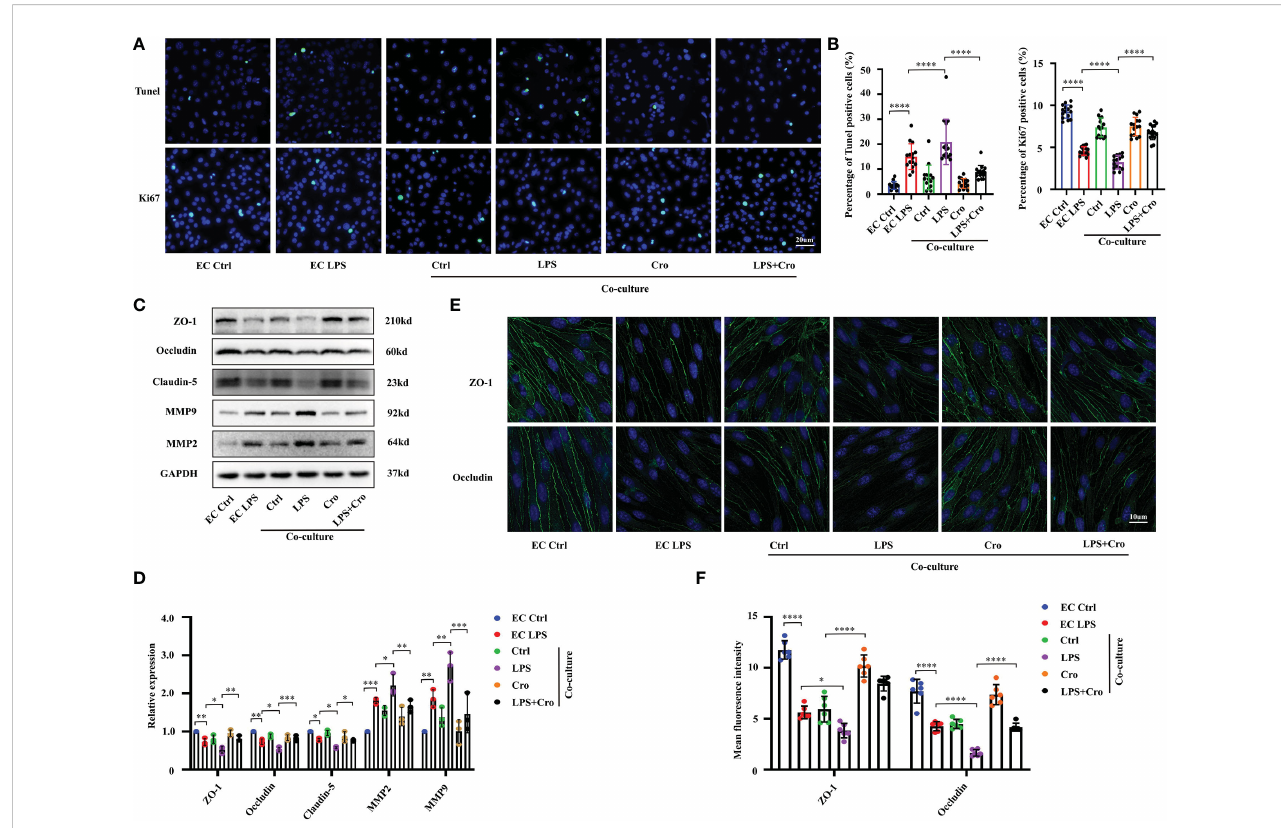
FIGURE 6 Cromolyn treatment protected BMVEC functions from LPS-induced MCs activation. (A) Apoptotic BMVECs and Ki-67-positive cells were examined by Tunel staining and Ki-67 IF staining, respectively (400x, n=3). (B) Quanti fi cation of Tunel-positive and Ki-67-positive BMVECs (n=3). (C) Expression levels of MMP9/ 2 and TJ proteins (ZO-1, occludin and claudin-5) of bEnd.3 cells were analyzed by Western blot (n=3). (D) The expression of MMP and TJ proteins were quanti fi ed and normalized to GAPDH levels (n=3). (E) Expression levels of ZO-1 and occludin protein in bEnd.3 cells were examined by IF assay (800x, n=3). (F) . Expression levels of ZO-1 and occludin were quanti fi ed in bEnd.3 cells in IF assay (n=3). LPS, Lipopolysaccharide, MCs, Mast cells; BMVECs, Brain microvascular endothelial cells; TJs, Tight junctions; IF, immuno fl uorescence. (ns, no signi fi cance, * p < 0.05, ** p < 0.01, *** p < 0.001, **** p <